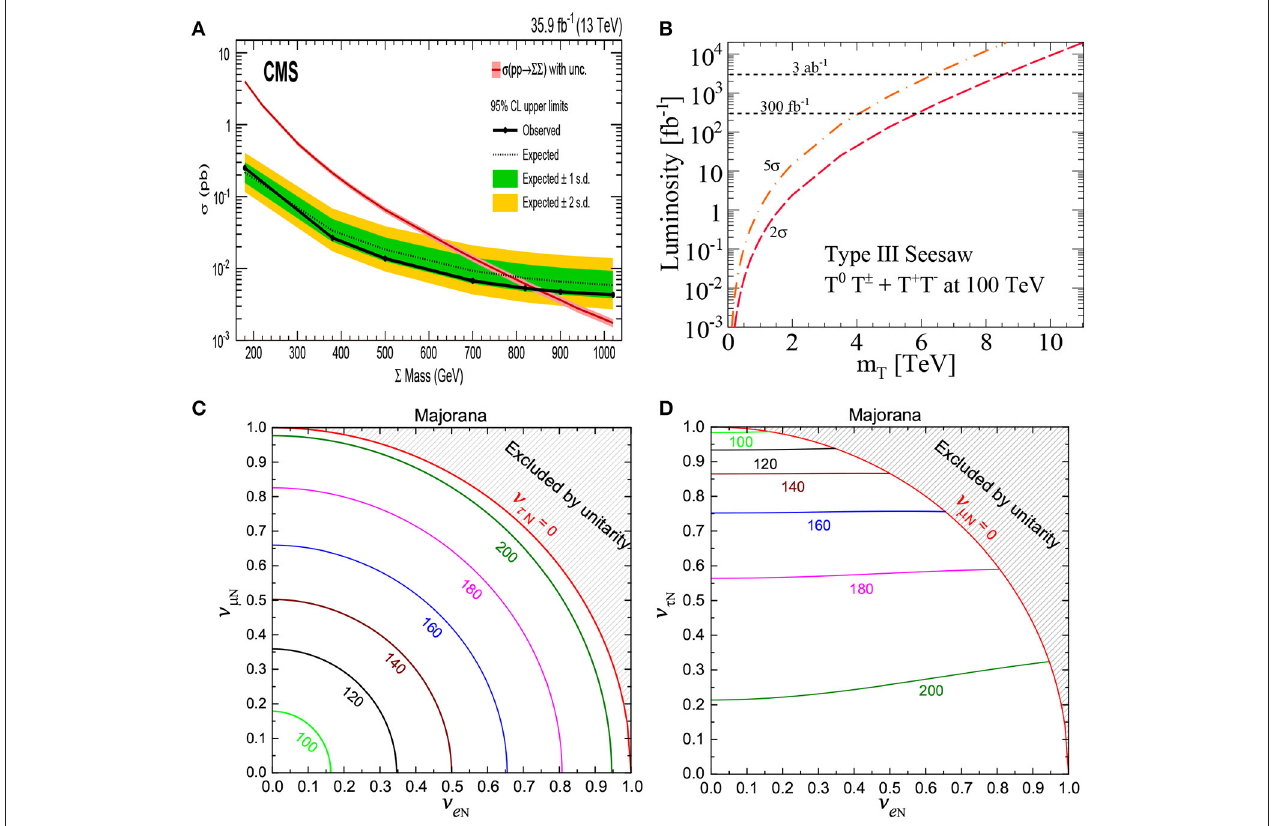
FIGURE 37 | (A) Limits on Type III leptons at √ s states [149, 275]. (C,D) Exclusion contours of doublet-triplet neutrino mixing in denote heavy neutral lepton mass in GeV) [